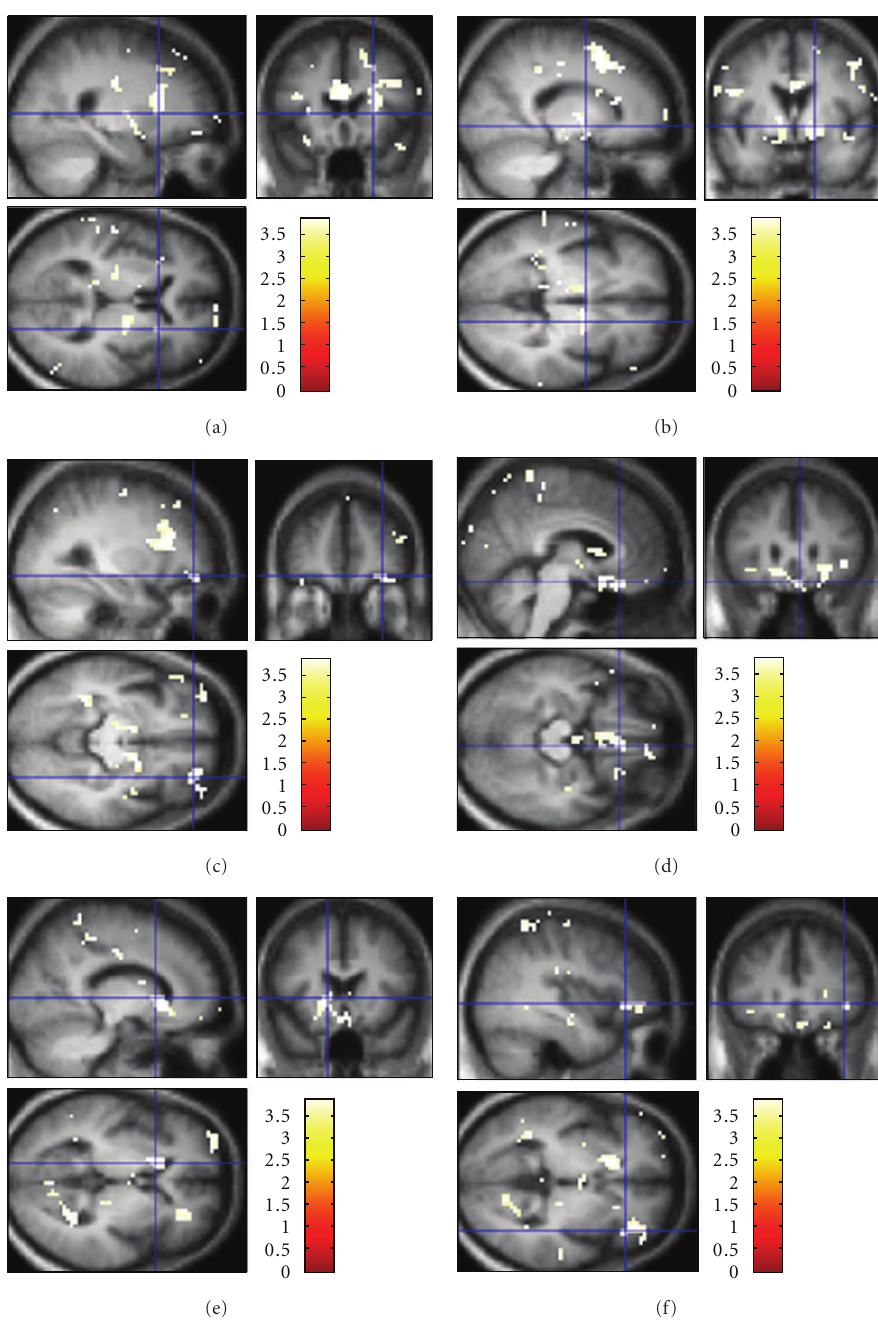
Figure 2: Statistical parametric (T) maps for correlations with valence. (a–c) Positive correlation with valence in (a) right putamen (22.5, 15, 6); (b) right medial globus pallidus (16.5, − 3, − 3); (c) right middle frontal gyrus (28.5, 42, − 9) (BA 11). (d–f) Negative correlation with valence in (d) right subcallosal gyrus (4.5, 24, − 15) (BA25); (e) left caudate ( − 13.5, 12, 3); (f) right inferior frontal gyrus (38, 27, 0)